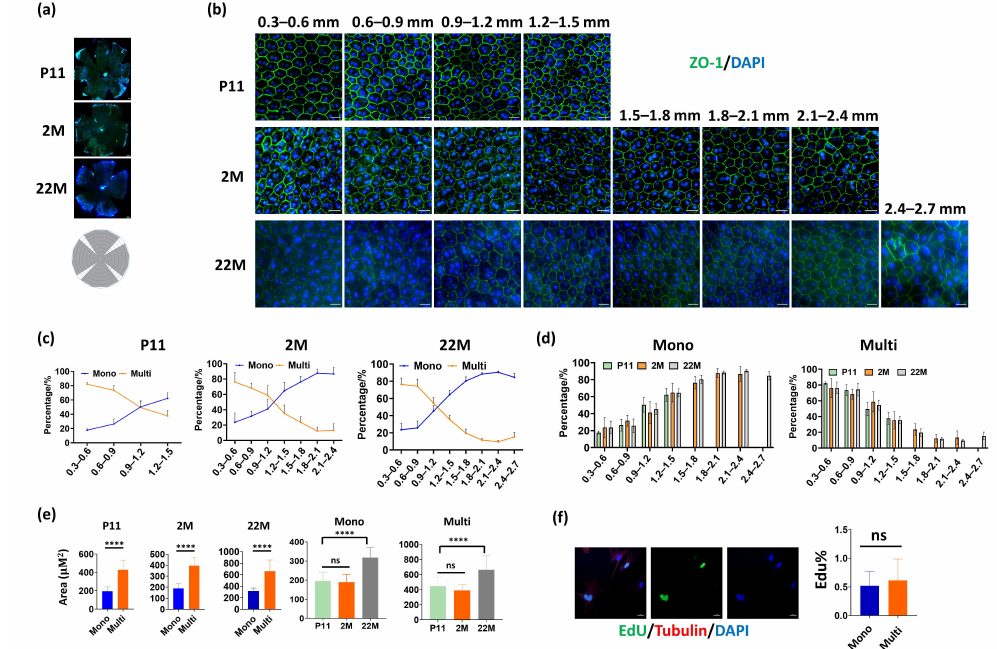
Figure 1. Distribution of mononucleated and multinucleated cells in mouse RPE of different ages. ( a ) IF analysis was performed on whole-mount RPE of postnatal day 11 (mice that had just opened